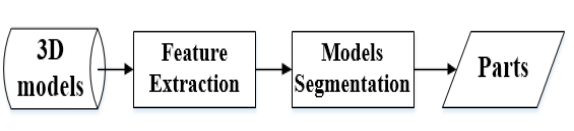
Figure 1. K-means algorithm process diagram